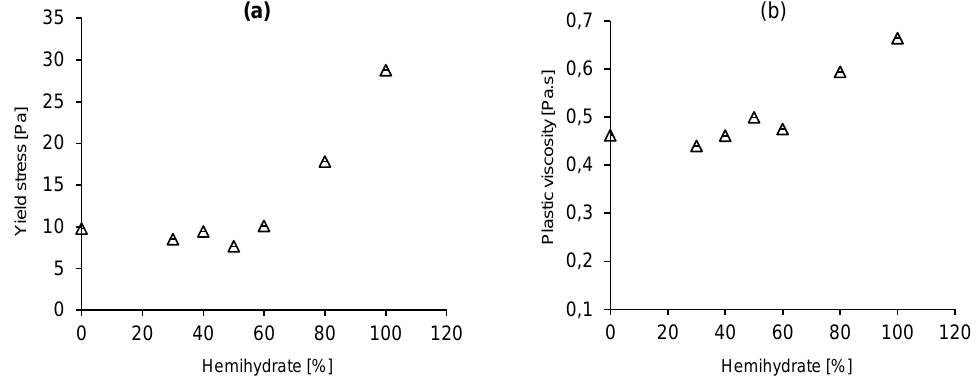
carbonated phases are depicted between a temperature range of 600-900 ∘